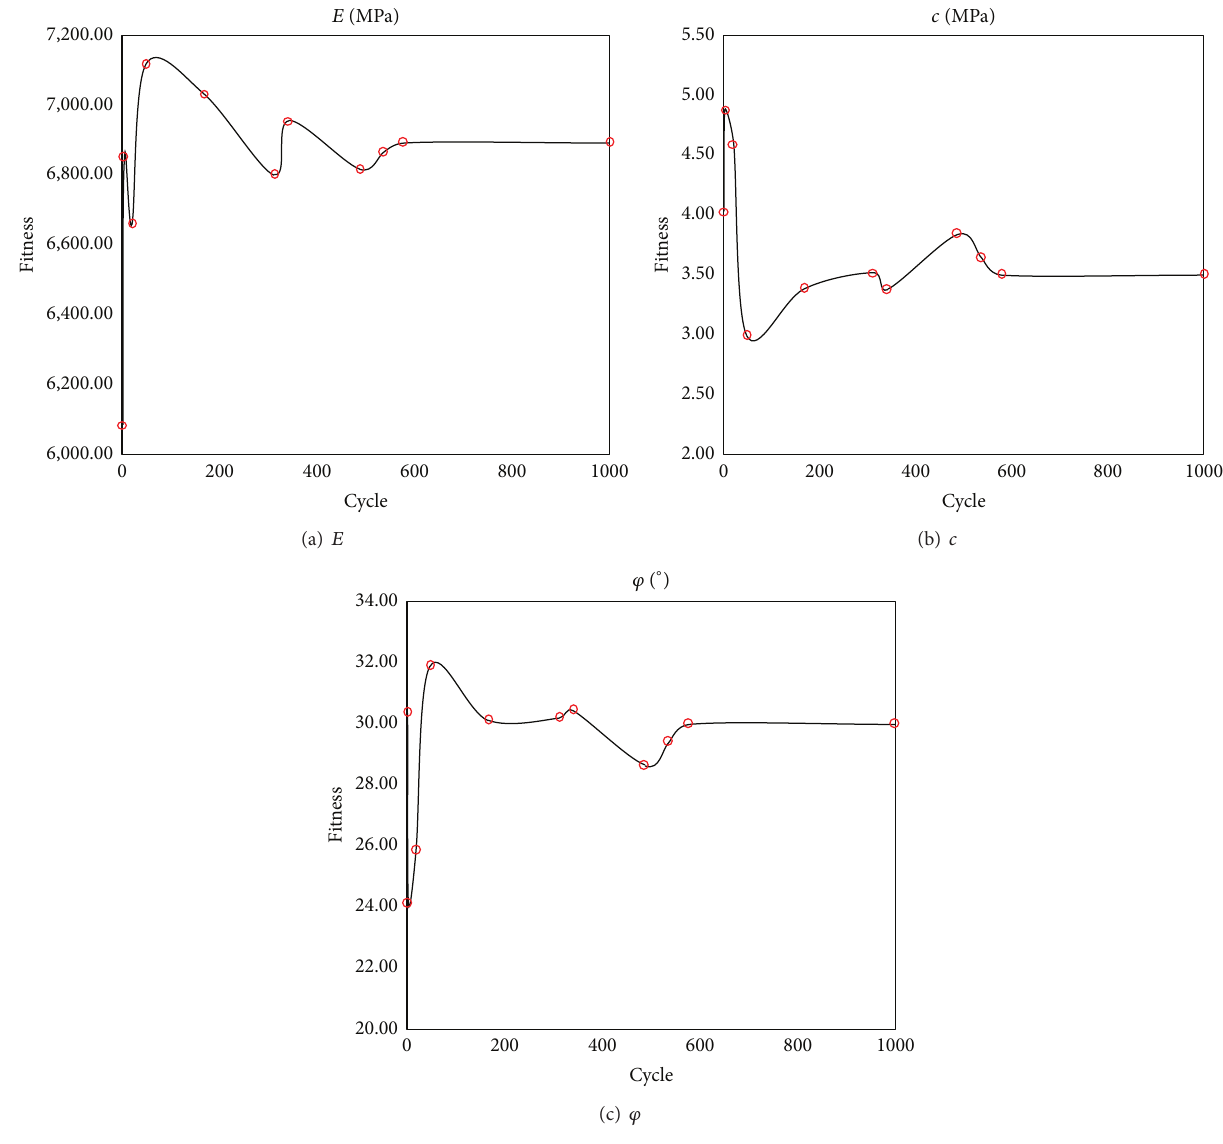
Figure 7: The variation of identified parameter with the